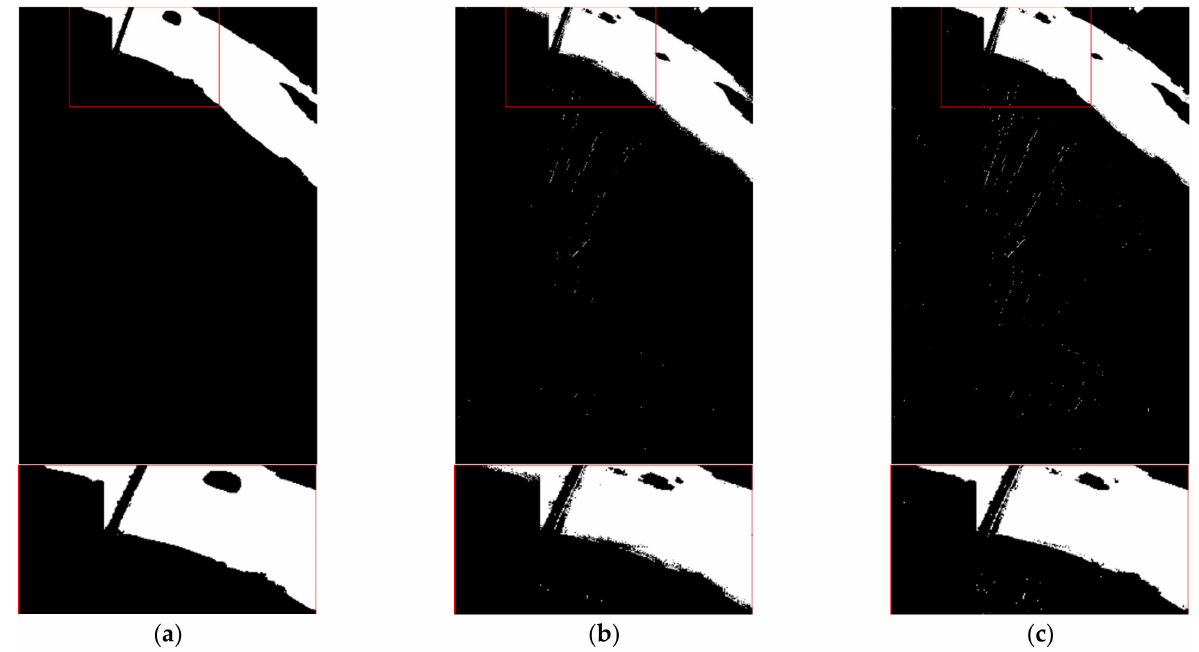
Figure 5. Extraction results of water body and partial enlarged image: ( a ) Ground truth information; ( b ) NDWI extraction result; ( c ) BAND32 extraction